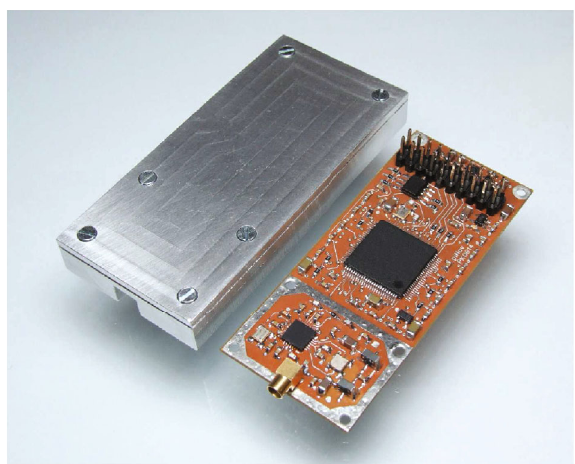
Figure 6: Photo of piNAV GPS receiver.